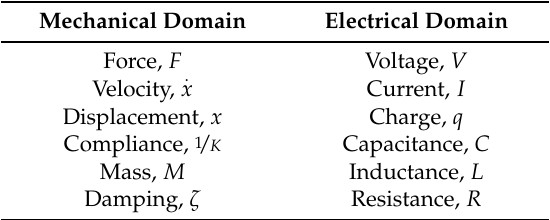
Table 1. Correspondence between electrical and mechanical